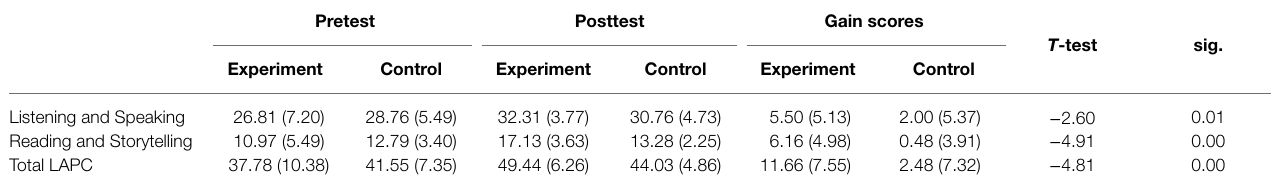
TABLE 2 | Means, SDs, and t -tests results for the LAPC tasks in pretest and posttest (Experiment group: n = 32; Control group: n =